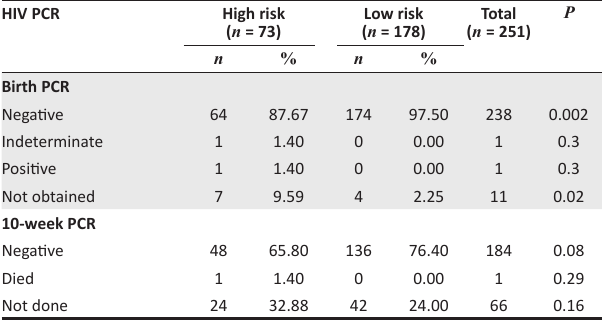
TABLE 2: Birth and 10-week polymerase chain reaction.